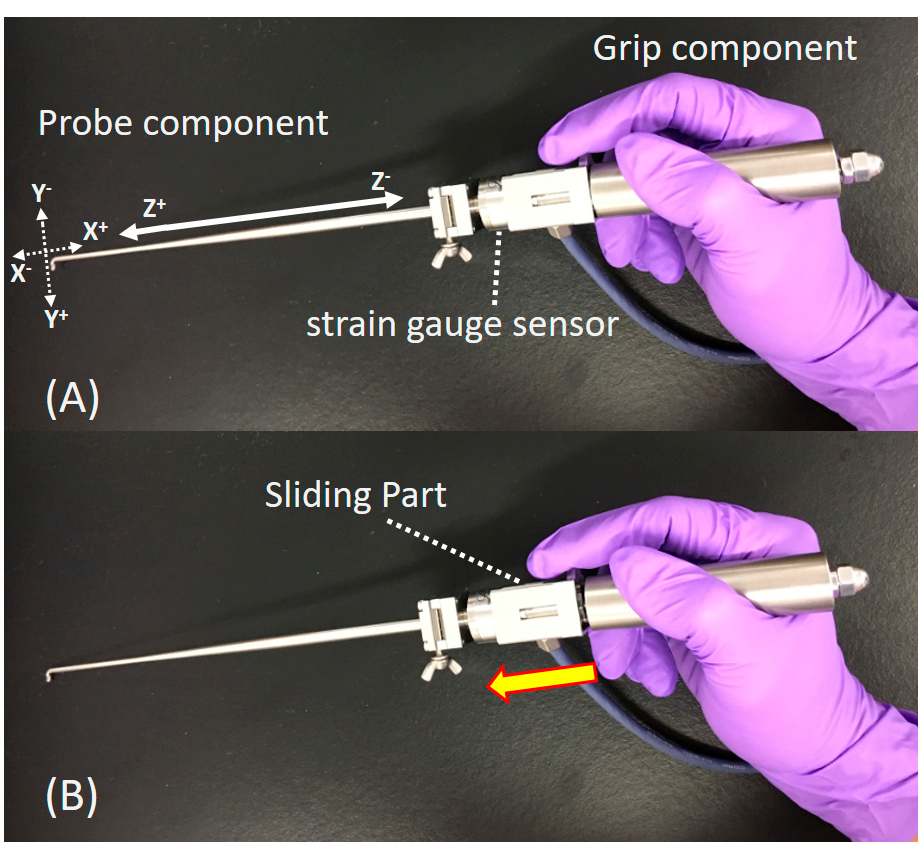
Figure 1. The probing device. The device consists of a probe component with a half-length size and a grip component. A strain gauge sensor is embedded at the top of the grip component, which connects with the probe component (Figure 1A). The sensor on the probe measures force in three axes, indicated by one solid and two dotted arrows, at the tip of the probe. The solid arrow is along the probe axis, and the two remaining dotted arrows are perpendicular to the probe axis. A sliding part (which moves forward in the direction of the yellow arrow) at the grip component has been added to control the distance while pulling and pushing of the probing in the Z direction (Figure 1B).